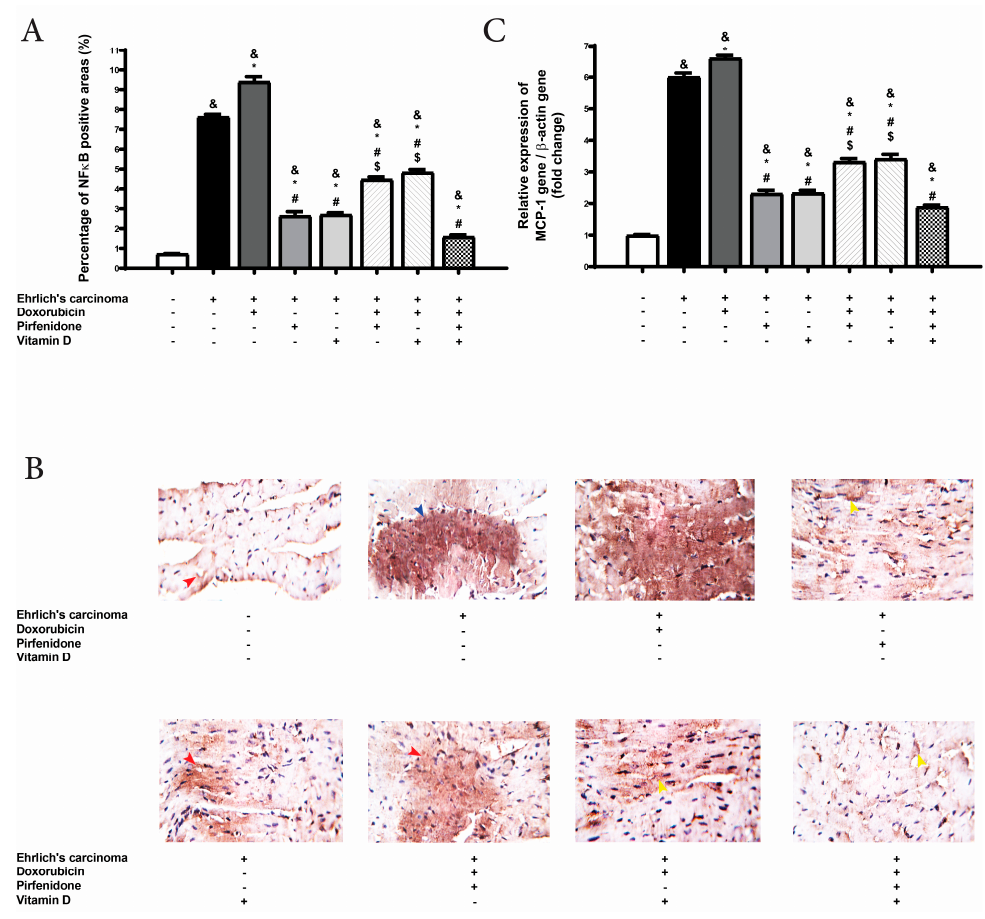
Figure 2. Effect of individual treatment with doxorubicin (15 mg/kg; i.p.), pirfenidone (500 mg/kg; p.o.) or vitamin D (0.5 μ g/kg; i.p.) and their combinations on cardiac expression of NF ‐κ B, and MCP ‐ or vitamin D (0.5 µ g / kg; i.p.) and their combinations on cardiac expression of NF- κ B, and MCP-1 in immunostaining for NF- κ B in experimental groups. ( B ) Photomicrographs showing cardiac expression of NF- κ B. ( C ) RT-PCR measurement of MCP-1 in cardiac tissue. & p < 0.05 with respect to